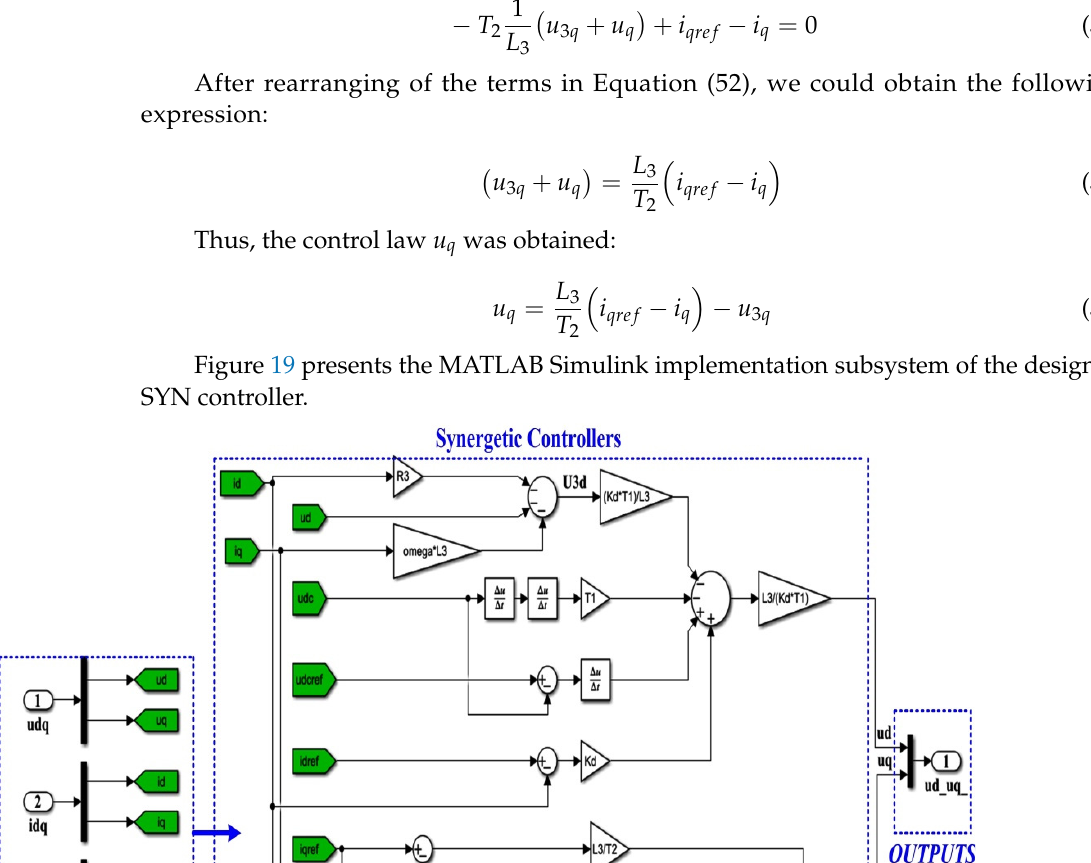
Figure 20. The model MATLAB Simulink implementation of the control system for the GC-PV ar- ray based on SMC and SYN controllers using the RL-TD3 agent for the correction of the control signals.